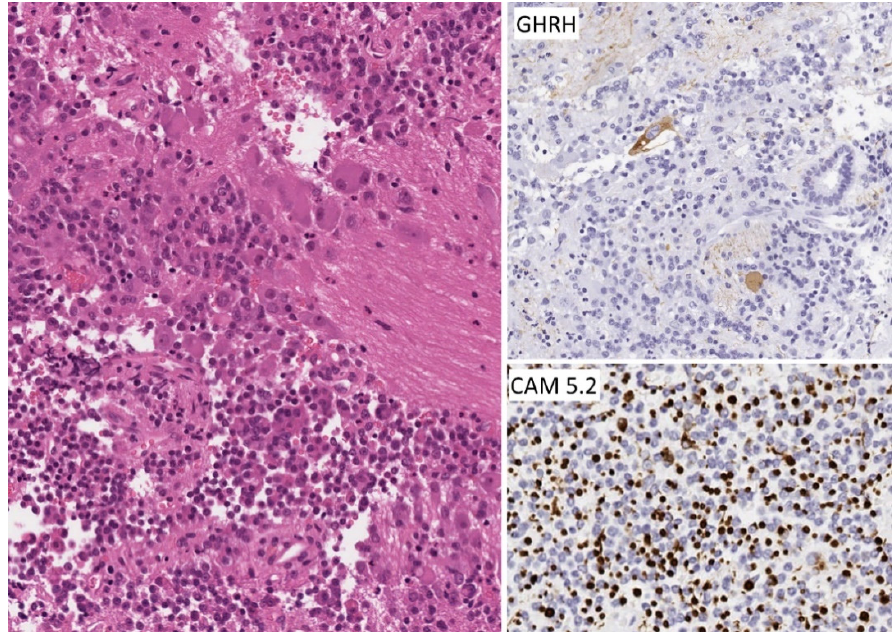
Figure 12. Morphology of hypothalamic gangliocytoma with sparsely granulated somatotroph tumor. This tumor is composed of two elements; the bulk of the lesion is a sparsely granulated somatotroph tumor similar to that shown in Figure 3, but there are scattered areas of neuropil with large neurons, known as “ganglion cells”, some of which are binucleate. The neurons contain immunoreactivity for GHRH, whereas the somatotrophs have fibrous bodies that are decorated by the CAM5.2 stain for keratins.